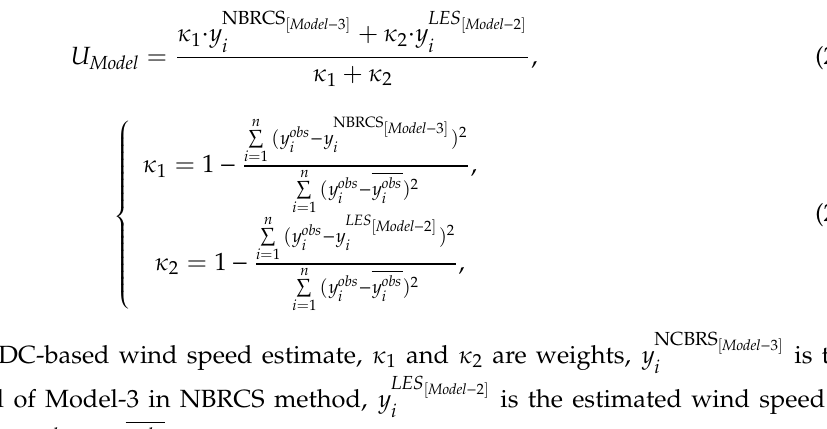
Figure 11. Specular point trajectory distribution. The red trails represent the locations of the reflection points, the green patches represent the Earth ’ s land, and the light blue patches represent